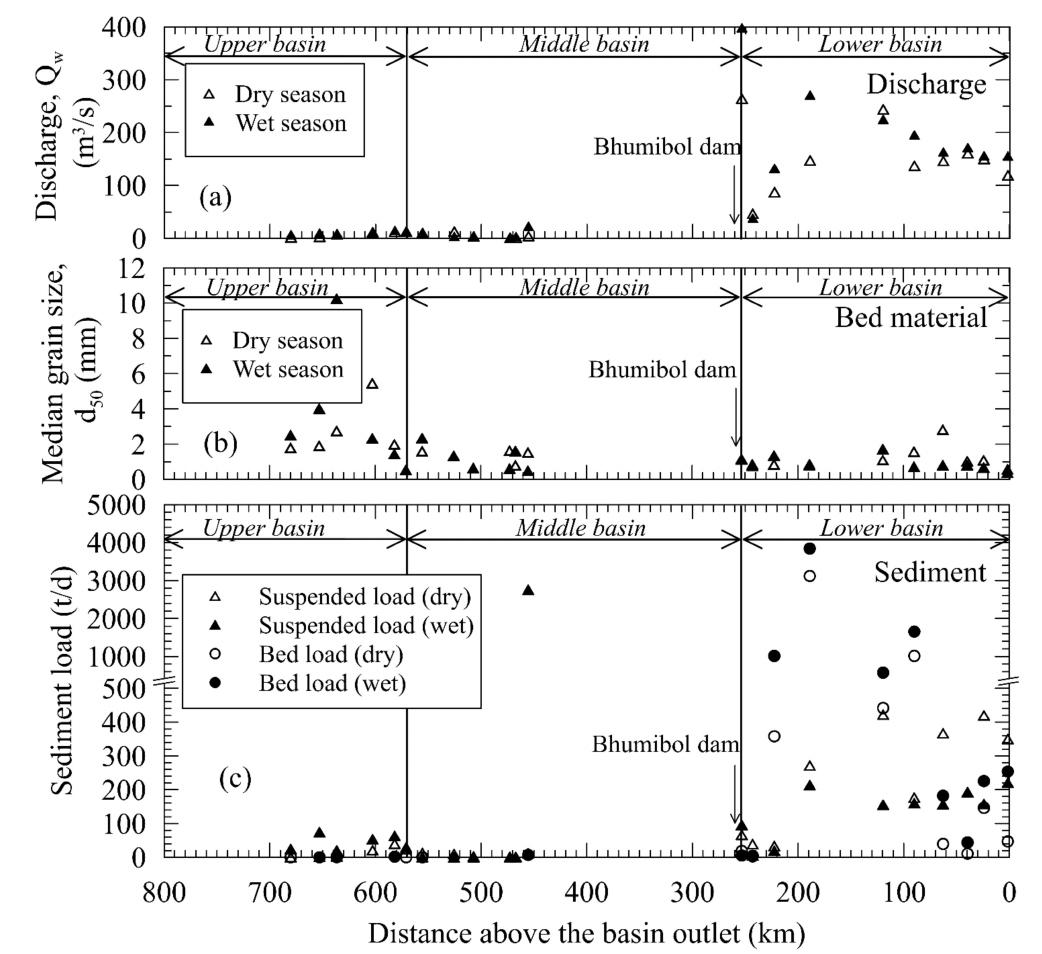
Figure 5. Observations along the Ping River during 2019: ( a ) river discharge; ( b ) median size bed material (d 50 ); ( c ) sus- pended sediment load and